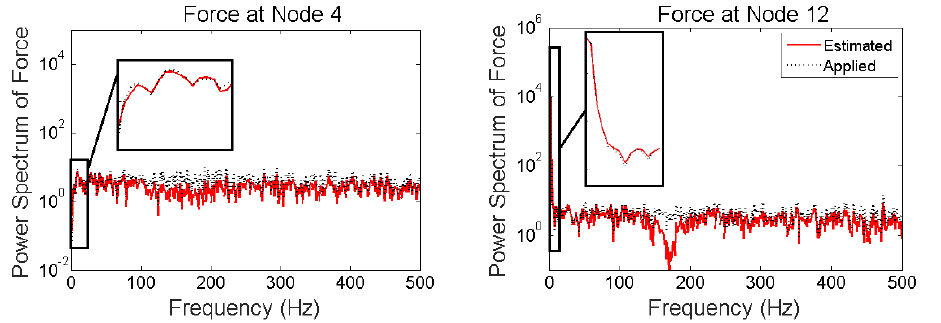
Figure 18. Frequency content of applied and estimated forces at Nodes 4 and 12 for “case